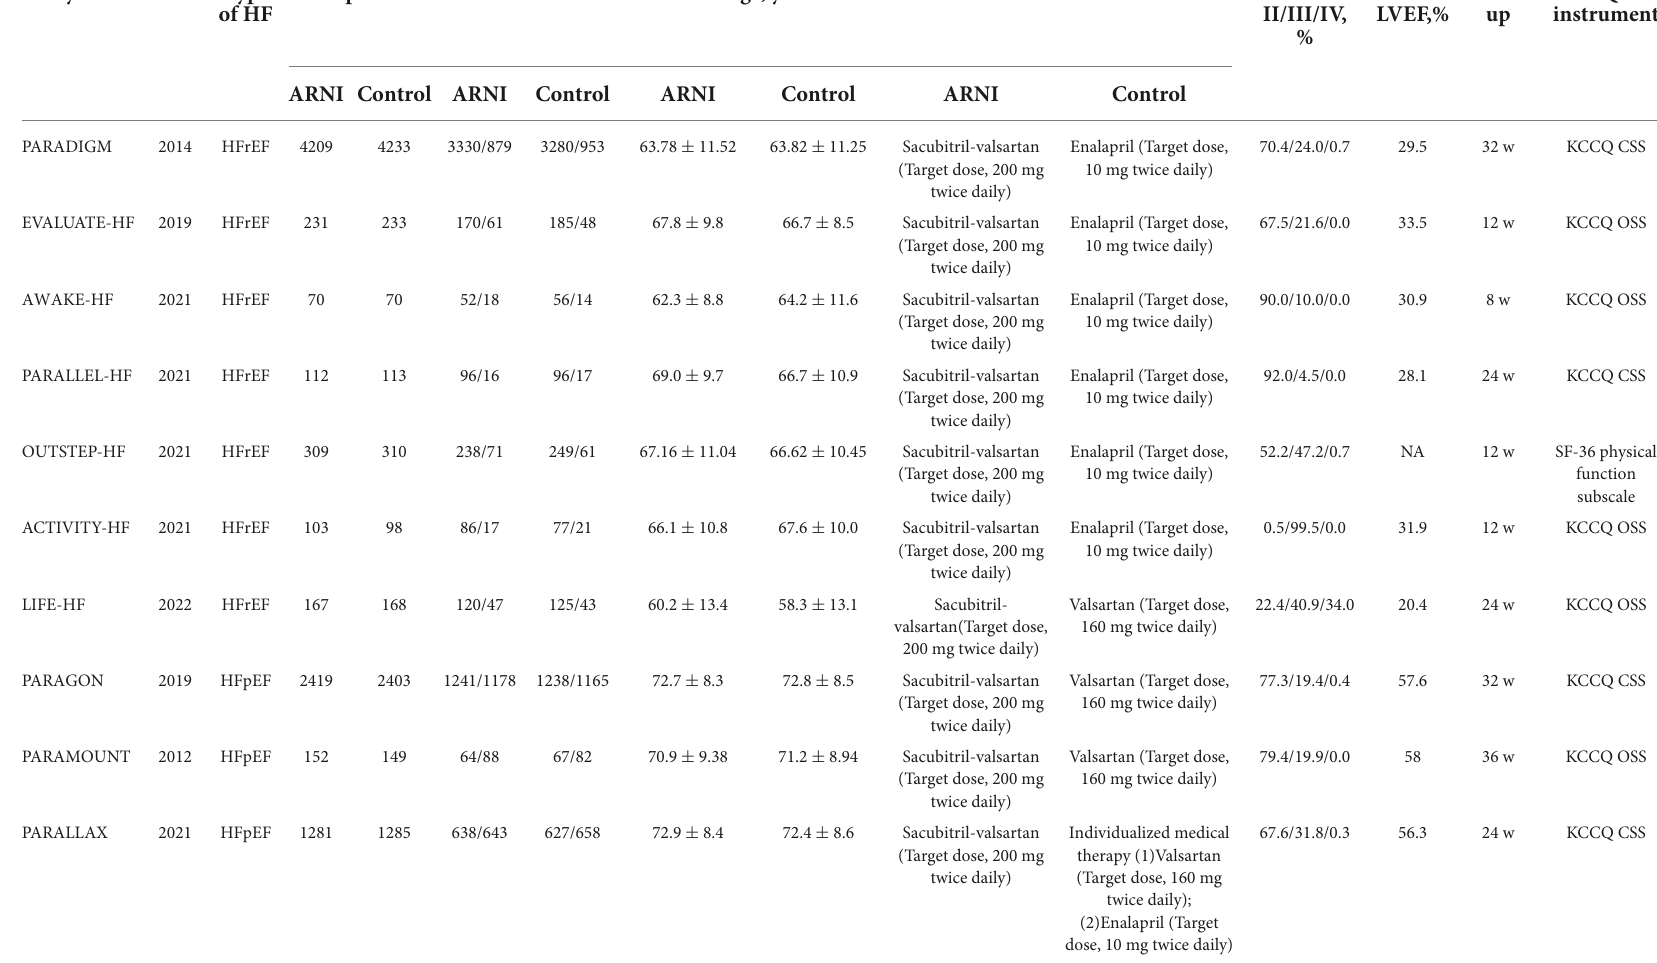
TABLE 1 Basic characteristics of included